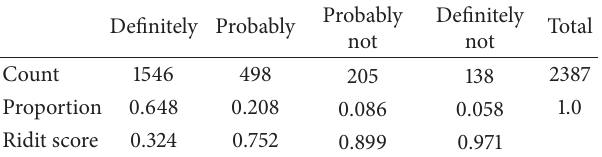
Table 3: Responses about belief in heaven